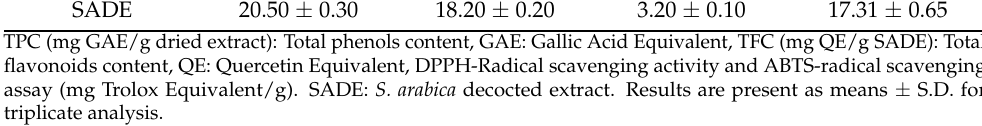
Table 2. Phenols, flavonoids and antioxidant activity of Salicornia arabica decocted extract (SADE). Parameters TPC TFC DPPH ABTS SADE 20.50 ±